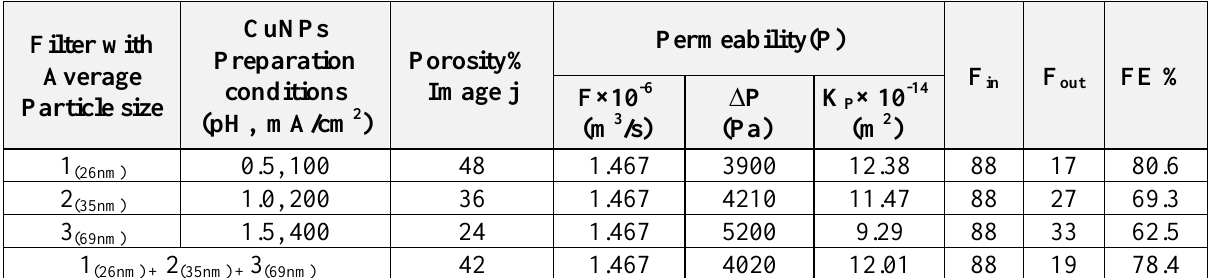
Table 3: Porosity, permeability and filtration efficiency of CuNPs filter